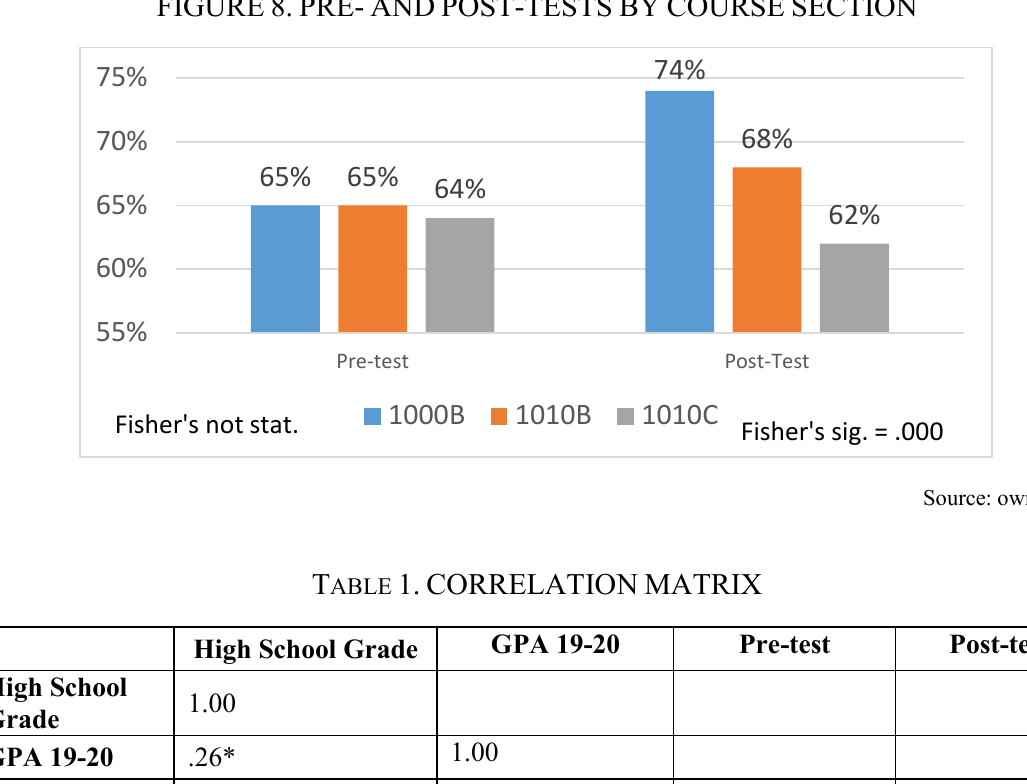
FIGURE 8. PRE- AND POST-TESTS BY COURSE SECTION